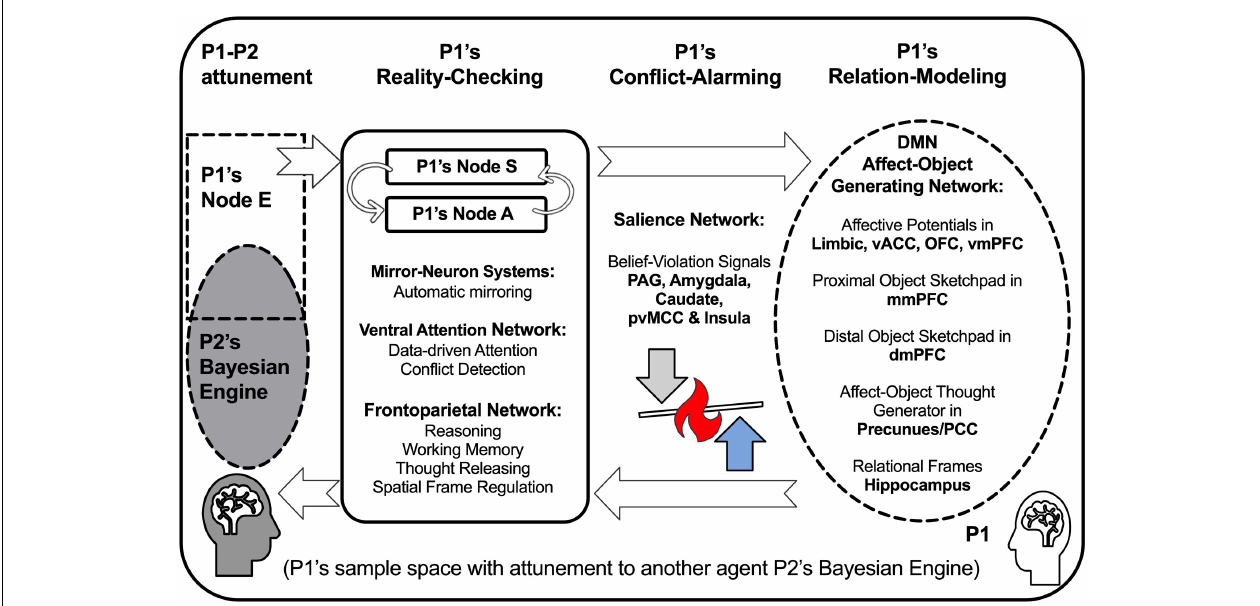
FIGURE 4 | Bayesian Engines in a state of attuning to others, such that all agents (e.g., P1 and P2) in the system are present in the sampling space of their Bayesian Engines. Here, we focus on P1’s Bayesian Engine as an example, even though P2’s Bayesian Engine is also present in the same sampling space (denoted by the inclusion of P2 in P1’s sample space). The Bayesian Engine consists of three functional components, namely Relation-Modeling, Reality-Checking, and Conflict-Alarming. Relation-Modeling is a component, consisting of Node I, wherein conceptual thoughts involving self and others are generated in the Affect-Object Generating Network (part of Default-Mode Network, DMN) in a relational frame generated by hippocampus and parahippocampal cortex. Reality-Checking is a component, consisting of Nodes S and A, subserved by multiple brain networks for data detection, reality monitoring, and attention regulation, including the Mirror-Neuron System, Ventral Attention Network, and Frontoparietal Network. Conflict-Alarming is a component that can be triggered by excessive free-energy due to conflicts that violate one’s rigid beliefs, so conflicts can activate the brain regions in the Salience Network, including periaqueductal grey (PAG), amygdala, caudate nucleus, posterior ventral middle cingulate cortex (pvMCC), and anterior insula. We postulate that when a conflict between P1 and P2 occurs, P1’s Conflict-Alarming is triggered, then P1’s subsequent course of actions can bifurcate, pivotally depending on how P1’s Salience Network regulates other brain networks underlying Relation-Modeling and Reality-Checking, denoted by the up/down arrows near the flame: Post-conflict resilience will ensue if the activations of Salience Network consistently down-regulate pre-existing Relation-Modeling and up-regulate Reality-Checking, such that P1 can attune to P2 adaptively, which will ultimately reduce conflicts in the long run; conversely, identity-grasping beliefs and ego-preserving bias will be exacerbated if the activations of Salience Network consistently up-regulate pre-existing Relation-Modeling and down-regulate Reality-Checking, which will generate even more conflicts in the long